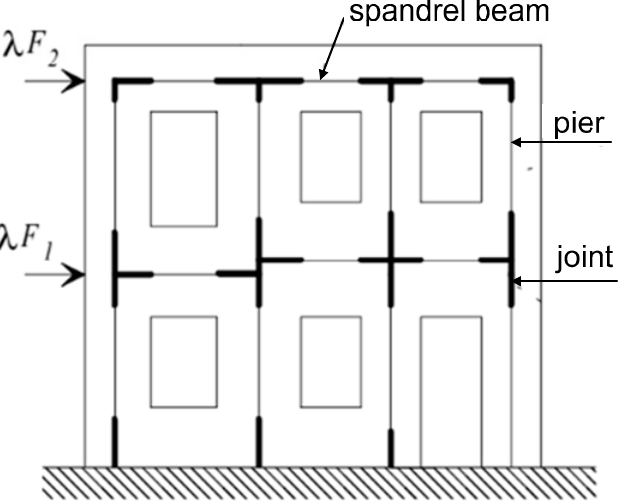
Figure 5. A schematic representation of equivalent frame model for planar walls with openings (Magenes, 2000, [134]).